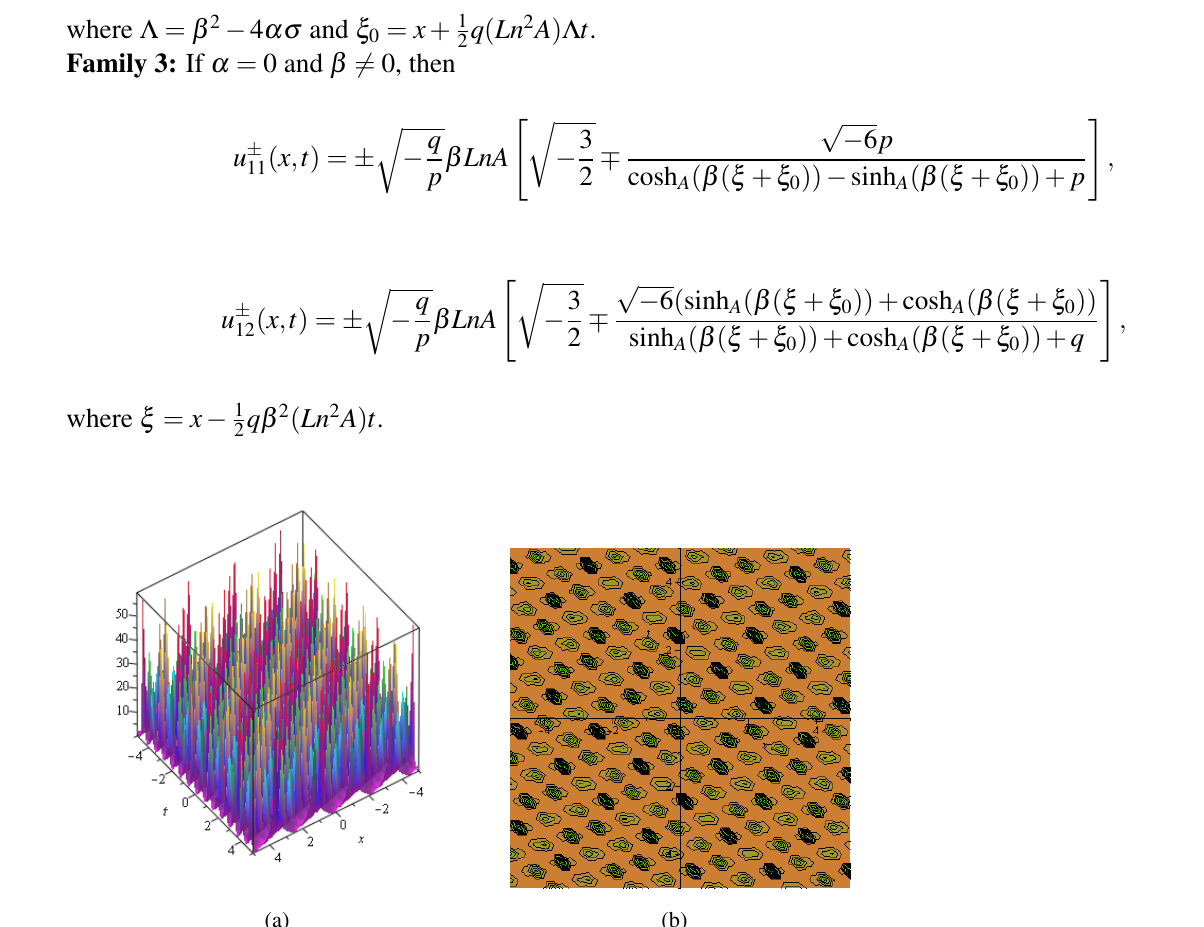
Fig. 4 Graphics of the solution equation (34) ( u − β = 3 , α = 1 , σ = 2 , A = e , p = 1 , q = 1 and ξ 0 = 0 (a) 3D plot and (b) contour